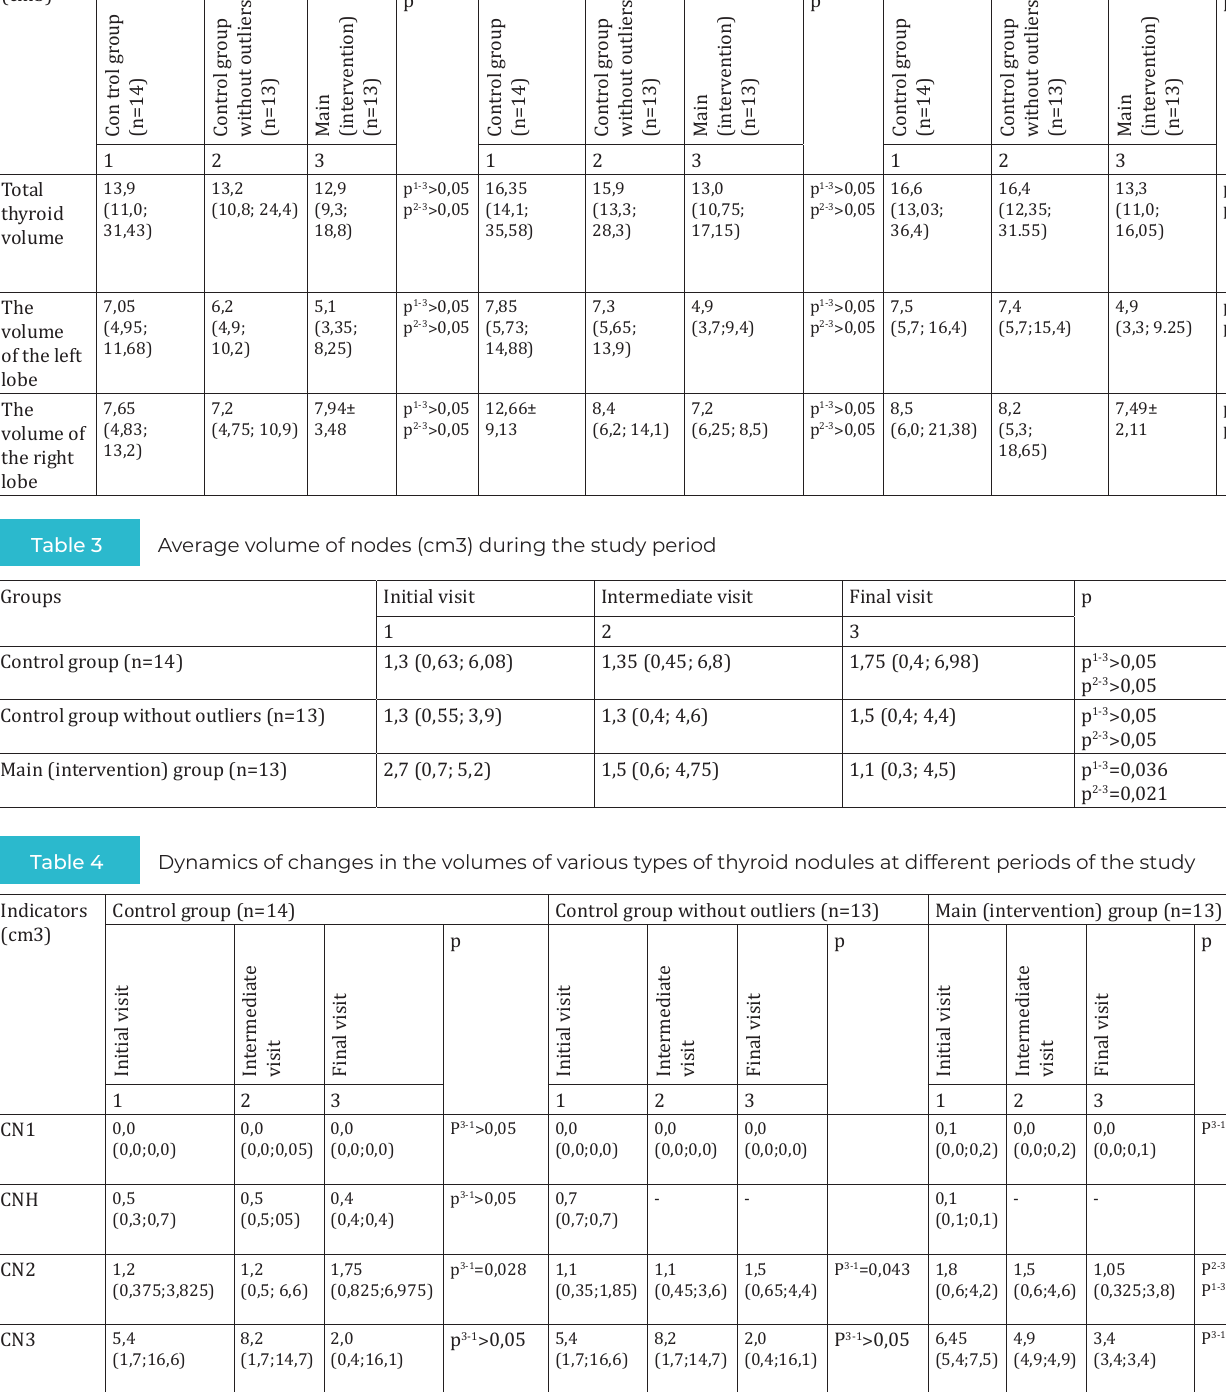
Comparison of the thyroid gland parameters between groups of patients at different periods of the study